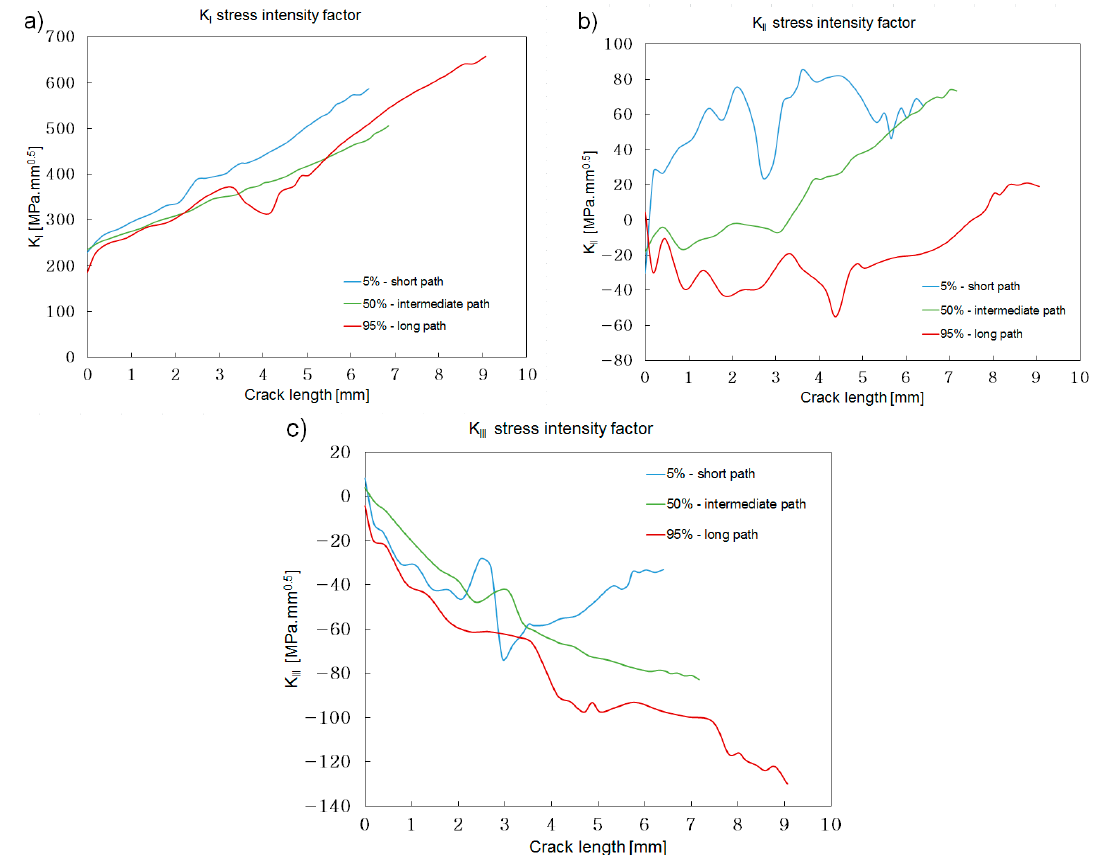
Figure 14. The 30° angle, long flank. Stress intensity along the three crack paths selected: ( a ) K I ; ( b ) K II ; ( c ) K III .